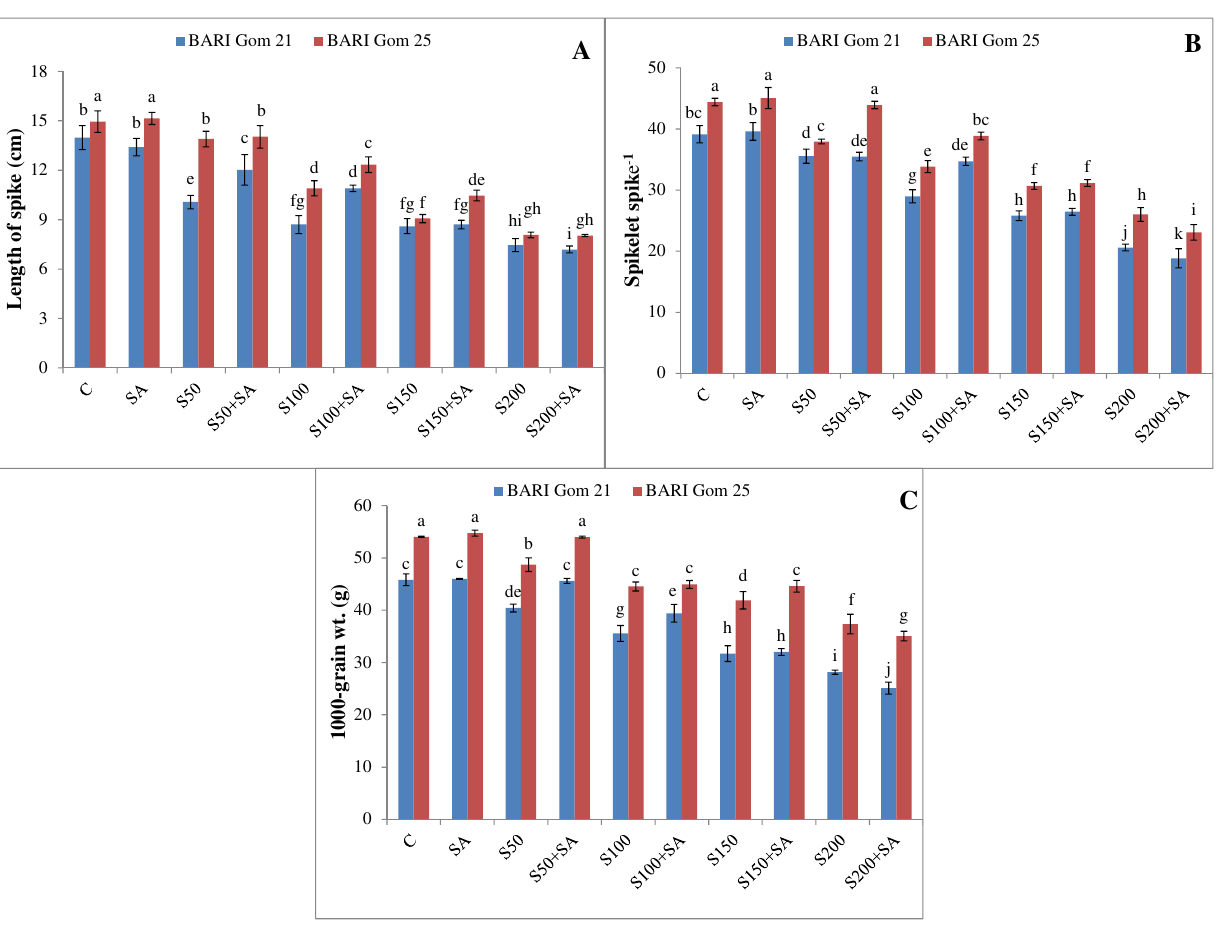
Fig. 7. ( A ) Length of spike, ( B ) spikelet spike -1 and ( C ) 1,000-grain wt. in salt sensitive and salt tolerant wheat plants induced by exogenous salicylic acid under salt stress. S50, S100, S150 and S200 indicate 50 mM, 100 mM, 150 mM and 200 mM NaCl, respectively. SA indicates 1 mM salicylic acid spray, respectively. Mean (±SD) was calculated from three replicates for each treatment. Values in a column with different letters are significantly different at p ≤ 0.05 applying LSD